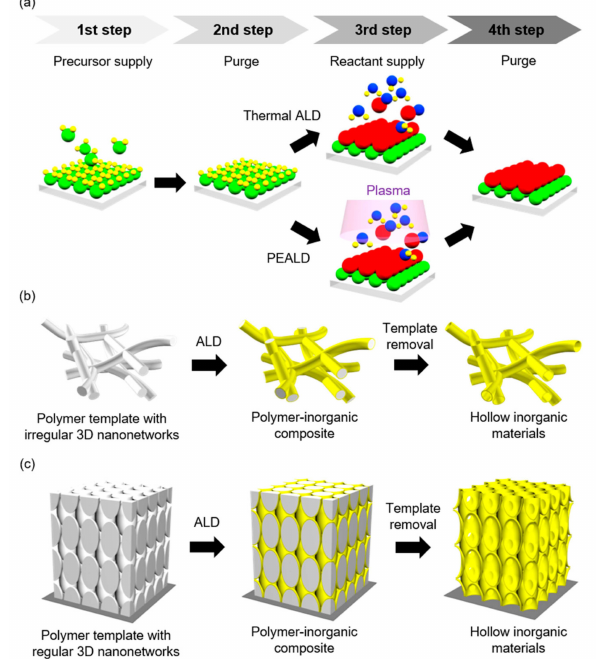
Figure 1. Schematic representation of ( a ) one cycle of thermal atomic layer deposition (ALD) or plasma-enhanced ALD (PEALD), ( b ) the fabrication process of polymer–inorganic composite or hollow inorganic materials from a polymer template with irregular three-dimensional (3D) nanonetworks, and ( c ) the fabrication process of polymer–inorganic composite or hollow inorganic materials from a polymer template with regular 3D